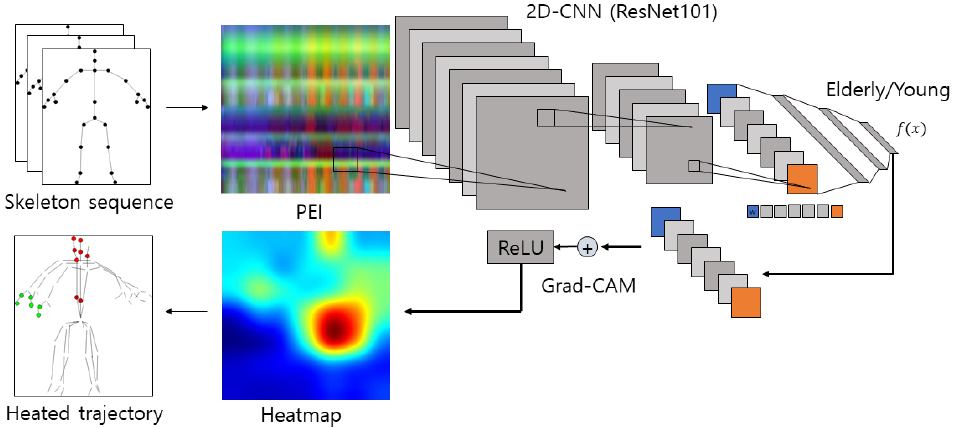
Figure 2. Diagram for the analysis method of behavioral characteristics.